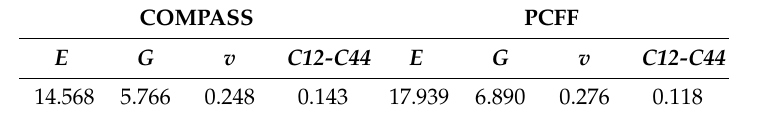
Figure 3. Changes of ( a ) the tensile modulus ( E ) and ( b ) the shear modulus ( G ) with DP simulated using the PCFF force field.